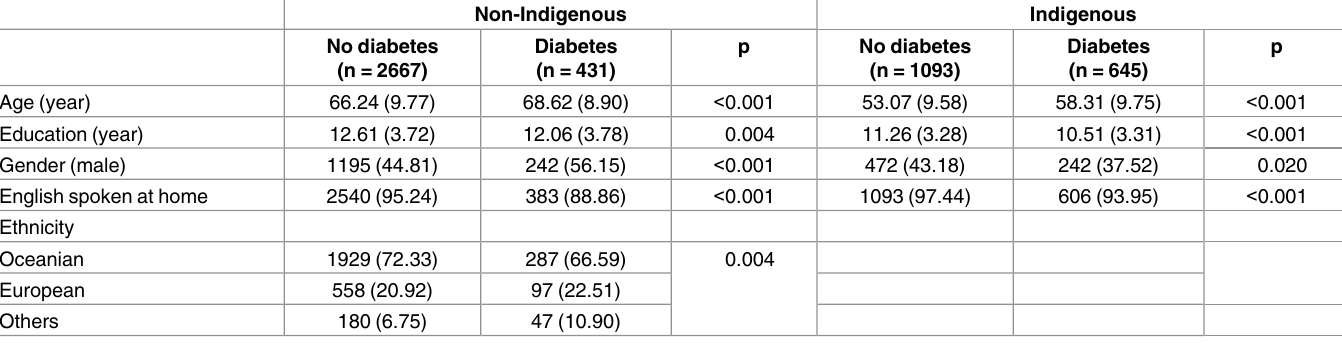
Table 1. Comparison of key demographics between participants with self-reported diabetes and those without, stratified by Indigenous status. Non-Indigenous